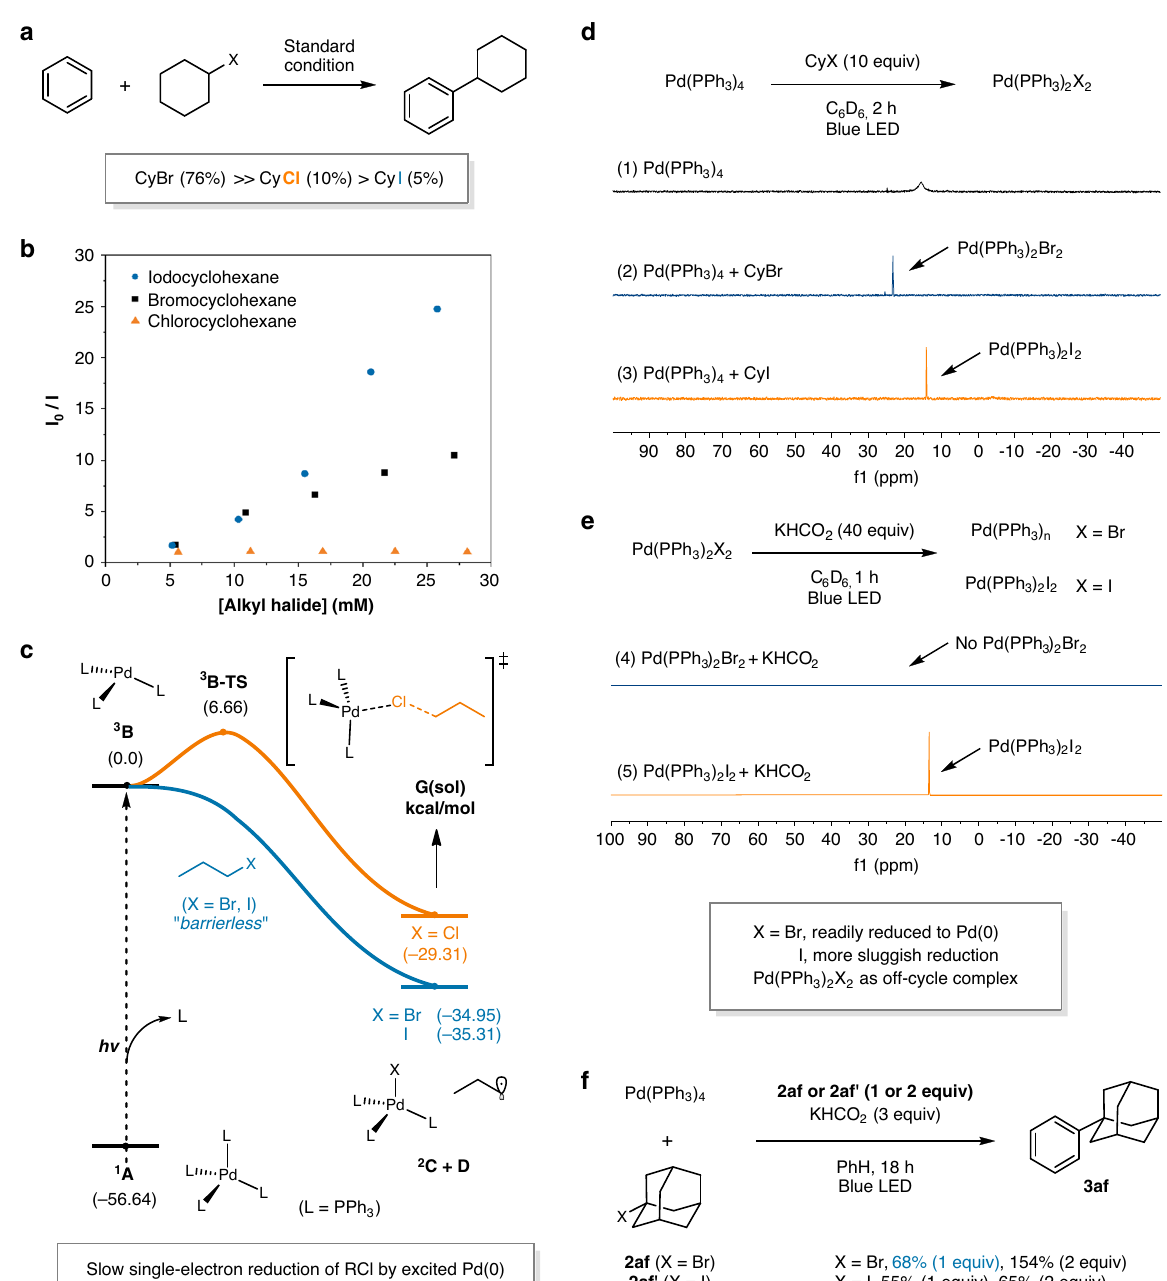
Fig. 5 Single-electron reduction of alkyl halides by photoexcited Pd(0). a Reactivity difference among alkyl halides. b Stern-Volmer experiment. c DFT modeling of single-electron reduction. d Formation of Pd(PPh 3 ) 2 X 2 from Pd(PPh 3 ) 4 and CyX. e Distinguished reactivity of Pd(PPh 3 ) 2 Br 2 . f Reactions with stoichiometric amount of Pd(PPh 3 ) 4